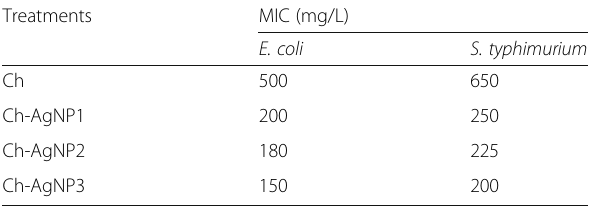
Table 2 In vitro antibacterial activity of with chitosan (Ch) and chitosan-silver nanoparticles (Ch-AgNPs) against E. coli and S.